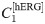
State transition diagram of the Markov model for the effect of PIP2 on the hERG channel.
C1[hERG]–C3[hERG] are closed states, O[hERG] is the open state, and I[hERG] the inactivation state. The transition rates have different values depending on whether PIP2 is absent or present [55].